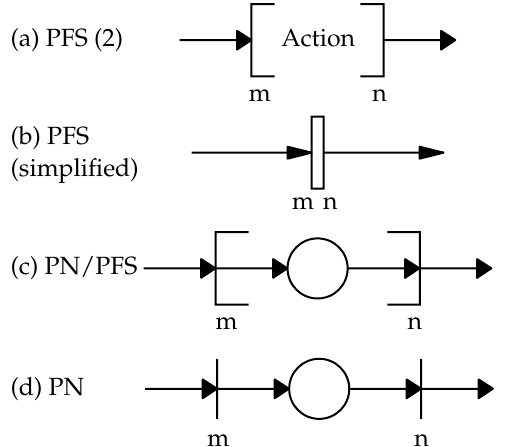
Figure 3. PFS model to PN conversion applying top-down methodology successive